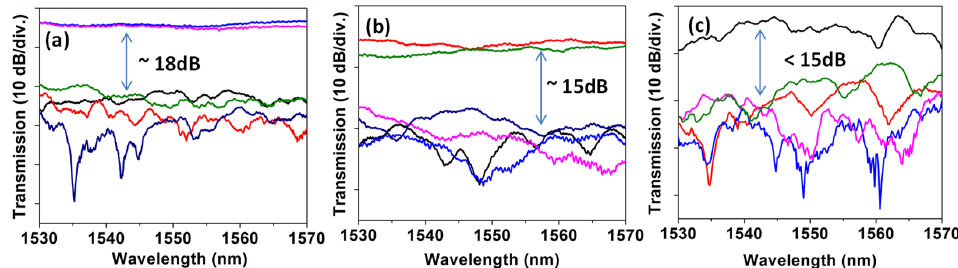
Figure 7. Measured relative crosstalk of the MDM power divider for power divisions of ( a ) TE 0 , ( b ) TE 1 , ( c ) TE 2 modes.